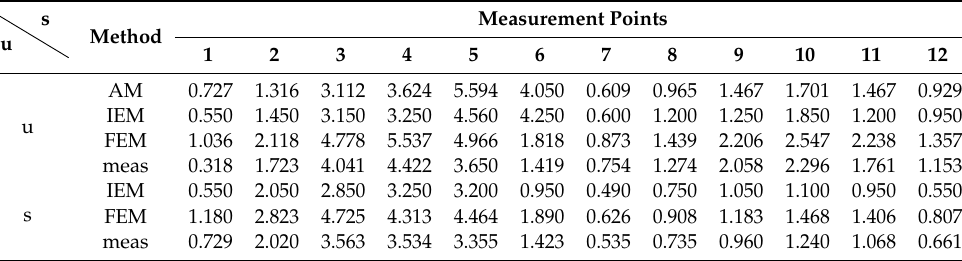
Table 3. Magnetic field intensity (in kA / m) at selected points of an unshielded (u) and shielded (s) three-phase busbar system manufactured by Holduct with current symmetry of I = 1